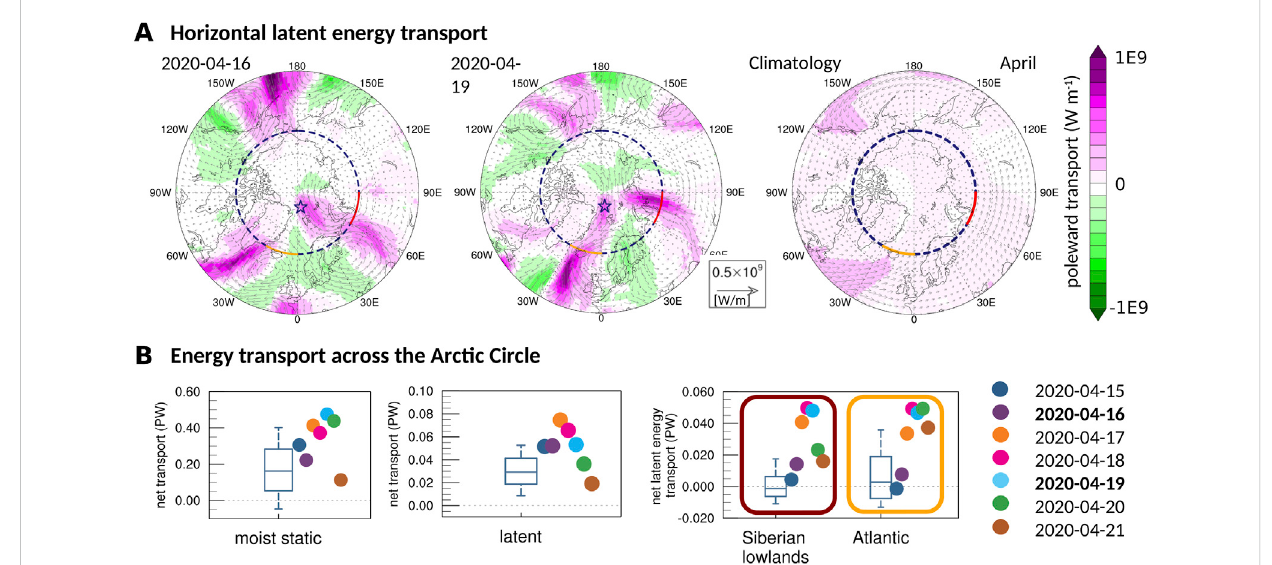
FIGURE 2 (A) Vertically integrated horizontal latent energy transport (arrows), poleward component (pink) and equatorward component (green) on 16 April (left),19April(middle),andAprilclimatologyfrom1979 – 2020(right),basedonERA5reanalysis.TheArcticCircleismarkedwithastippledline,theAtlantic segment in orange, the Siberian lowlands segment in red, the position of RV Polarstern with a star. (B) Daily mean net transport across the Arctic Circle in April; moist static energy (left), latent energy (middle), latent energy of Atlantic and Siberian lowlands segments (right). Box plots show the climatology of days in April 1979 – 2020 from ERA5 reanalysis. Whiskers show the lower decile, lower quartile, median, upper quartile, and upper decile. Colored dots indicate the days of April 2020, from 15 to 21 April.